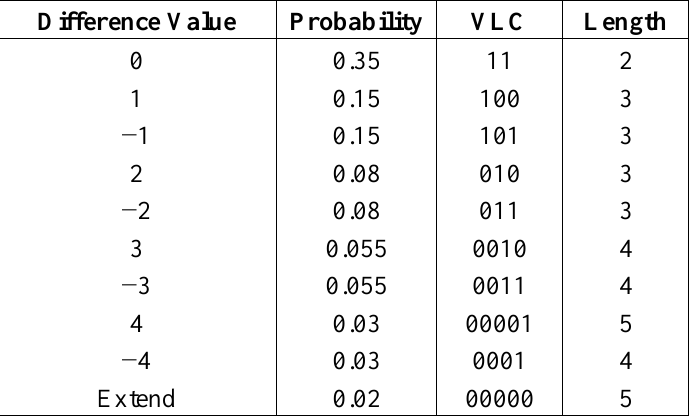
Table 1. The Entropy Coding Table.